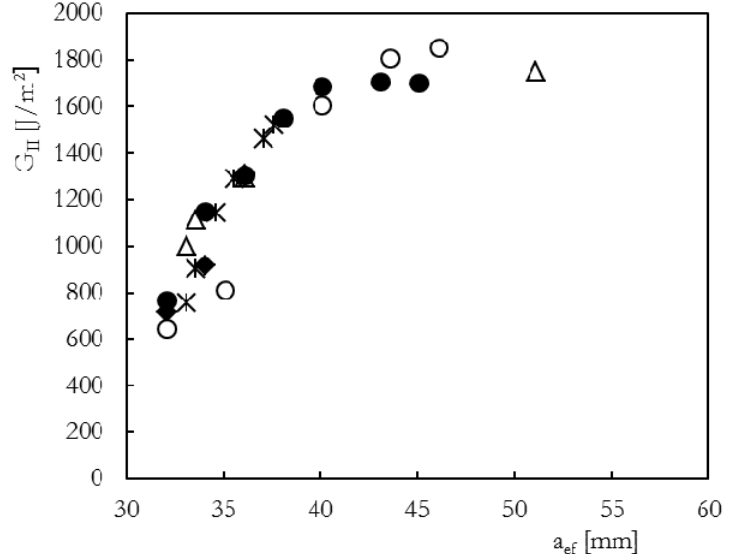
Figure 6: G II versus crack